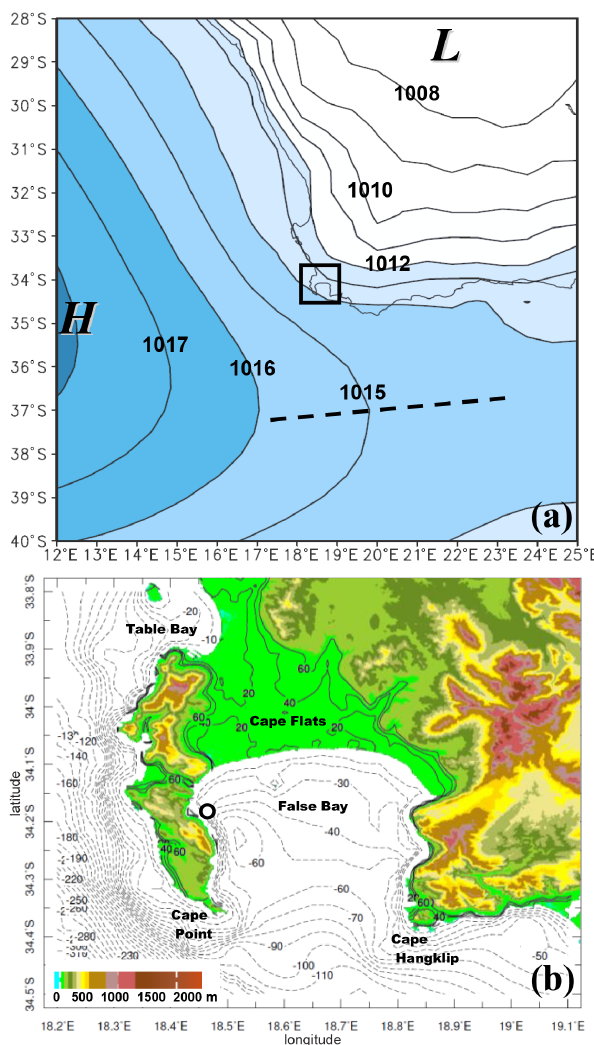
Figure 1. (a) Mean sea level air pressure in summer December 2012 to February 2013. The box denotes the False Bay area and the dashed line the subtropical ridge. (b) Topography (shading) and bathymetry contours; place names are labelled; dot is the IMT buoy–tide gauge–weather station off